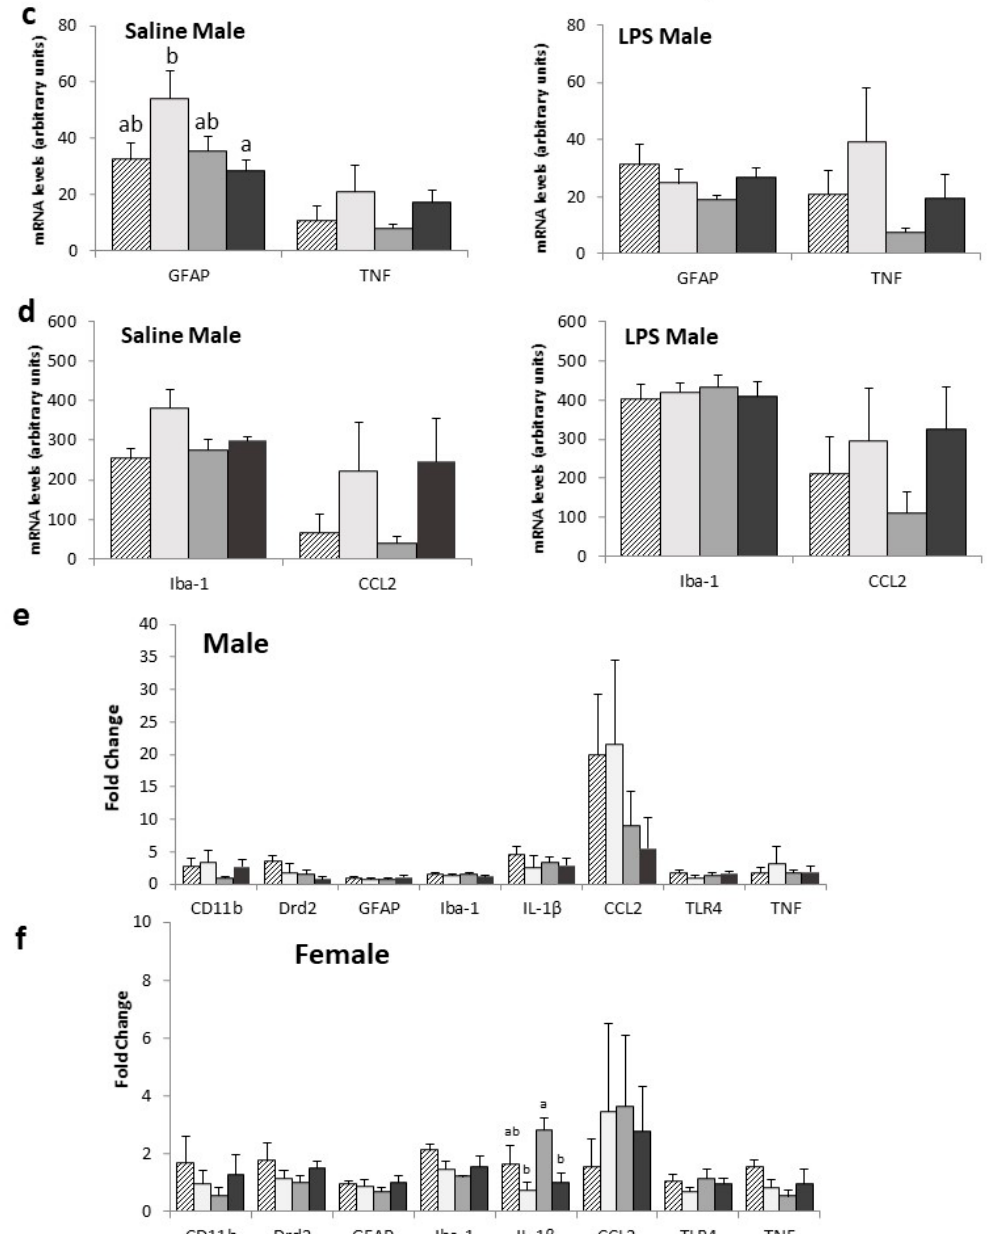
Figure 4. Gene expression in the hypothalamus; ( a ) saline- and LPS-injected male mRNA levels of CD11b and Drd2; ( b ) saline- and LPS-injected male mRNA levels of IL-1 β and TLR4; ( c ) saline- and LPS-injected male mRNA levels of GFAP and TNF; ( d ) saline- and LPS-injected male mRNA levels of Iba-1 and CCL2; ( e ) fold change in gene expression between LPS- and saline-injected males; ( f ) fold change in gene expression between LPS- and saline-injected females. Values are mean ± SEM ( n = 10–13 / group). Post hoc analysis is depicted with the superscripts a,b where groups without a common superscript di ff er ( p < 0.05) (i.e., a is di ff erent from b but ab is not di ff erent from a or b). CT: control; AB: antibiotic; PR: prebiotic; AB + PR: antibiotic plus prebiotic. There were no significant di ff erences in target genes between treatment groups in saline-injected females or LPS-injected females (Supplementary Figure S3). However, the fold change in the expression of IL-1 β in LPS- compared to saline-injected animals was 2.82-fold in PR, which was significantly greater than AB ( p = 0.012) and AB + PR ( p = 0.029) groups (Figure